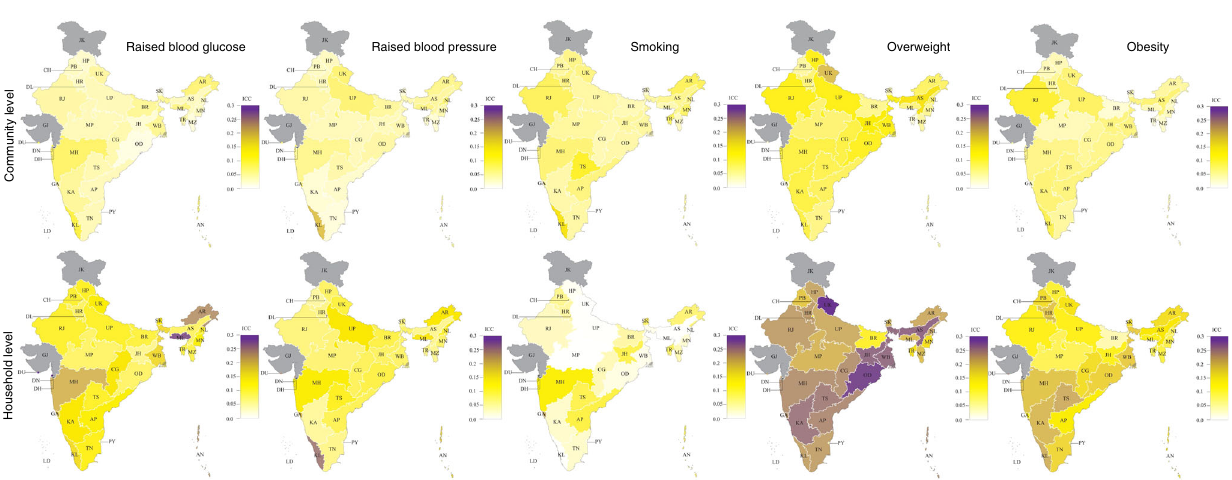
Fig. 1 Intracluster correlation coef fi cients at the household and community level by state. AN Andaman and Nicobar Islands, AP Andhra Pradesh,